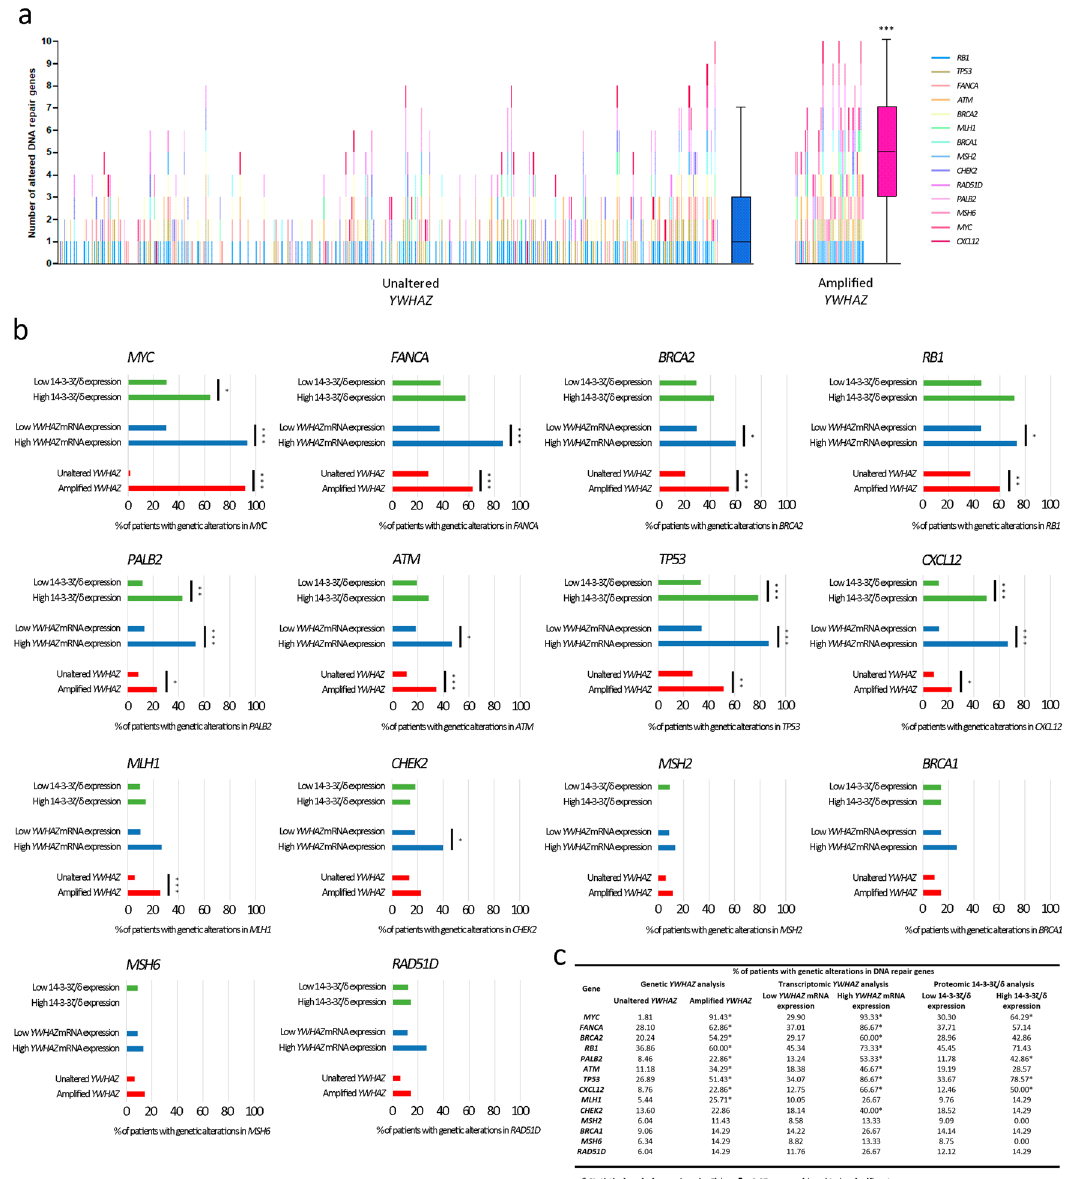
Fig. 6 Genetic alterations (ampli fi cation, gain, shallow deletion, deep deletion, and point mutations) in DNA repair genes in PCa patients with YWHAZ ampli fi cations and high YWHAZ mRNA and protein levels ( TCGA-PRAD data set, n = 499). a Mutational landscape analysis (ampli fi cation, gain, shallow deletion, deep deletion, and point mutations) of DNA repair genes in patients with no alterations in YWHAZ ( n = 331) and with ampli fi cations in YWHAZ ( n = 35). Each vertical line is a patient and the different colors represent alterations in a different gene, as speci fi ed in the references. The graph includes box plots showing the median number of altered DNA repair genes. The top and bottom of each rectangular box represent the 75th and 25th percentiles respectively, with the median indicated with a solid line inside the box. Horizontal bars extending from each box represent more extreme values de fi ned as 1.5-times the interquartile range (25th percentile subtracted from the 75th percentile) above the 75th percentile or below 25th percentile. Student ’ s t -test was used to ascertain statistical signi fi cance. b Bar plots representing the percentage of PCa patients that present genetic alterations in each DNA repair gene based on whether they have ampli fi cations in YWHAZ (red bars), high or low YWHAZ mRNA levels (blue bars), and high or low 14- 3-3 ζ / δ protein levels (green bars). c Comparative table of the percentage of patients that present genetic alterations in each DNA repair gene based on whether they have ampli fi cations in YWHAZ , high or low YWHAZ mRNA levels, and high or low 14-3-3 ζ / δ protein levels. Fisher ’ s exact test was used